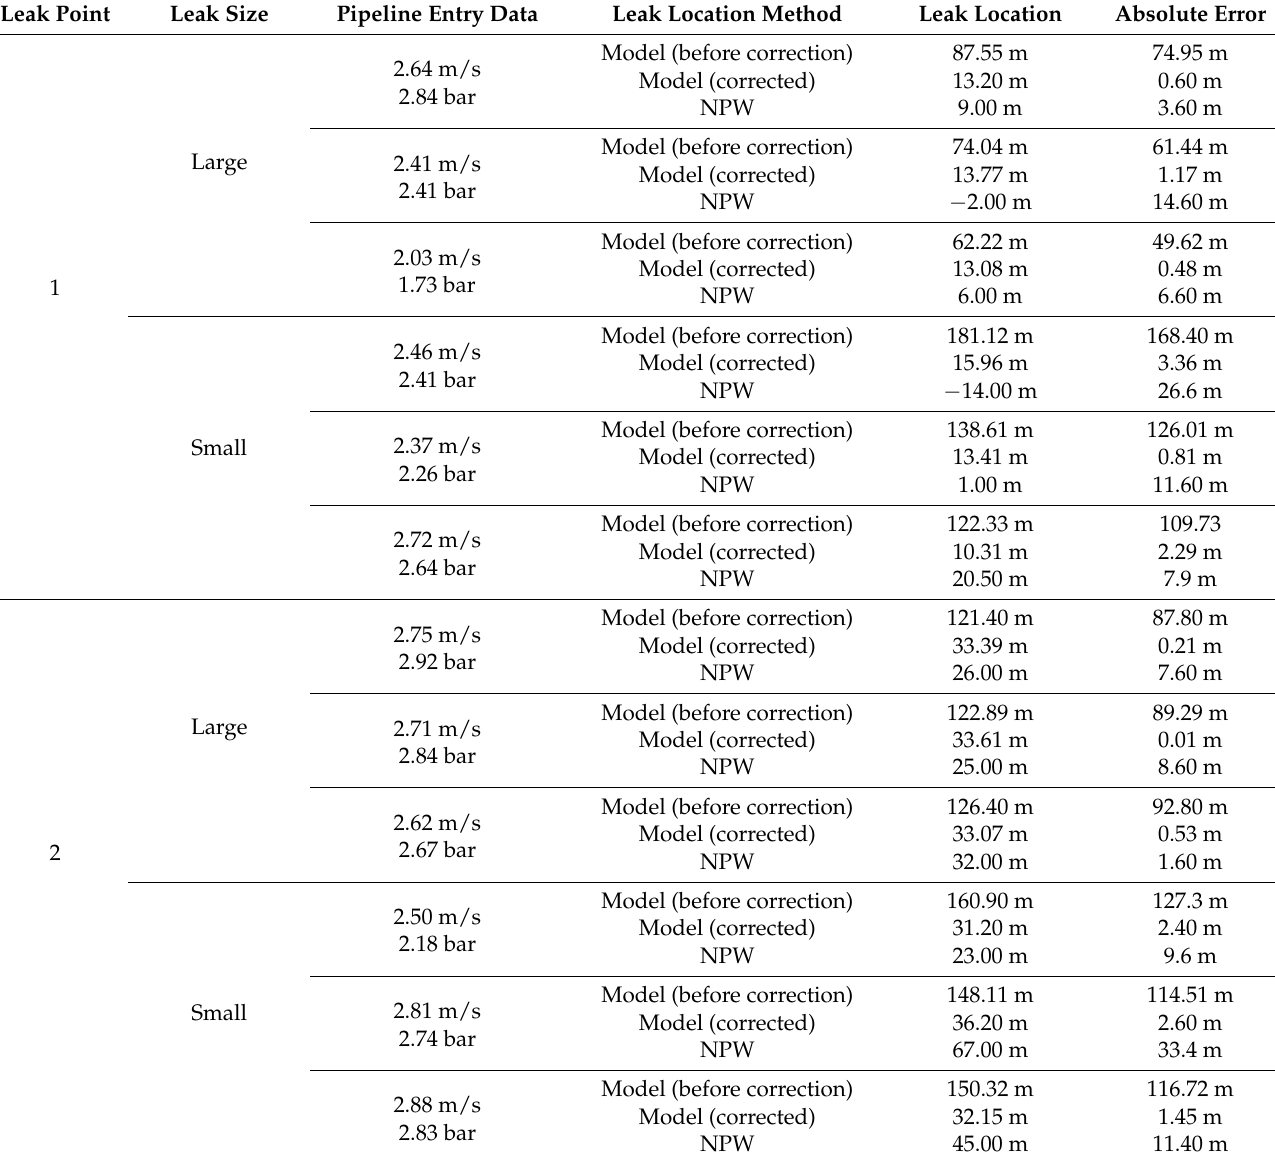
Table 3. Comparison of leak location of various